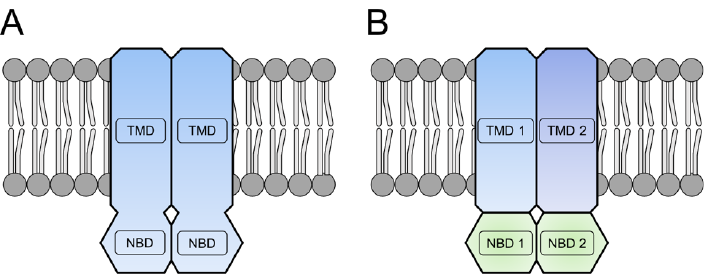
Figure 1. Domain organization of prokaryotic ABC exporters. ( A ) : Half-size homodimer. ( B ) : Single domain heterodimer. TMD = transmembrane domain. NBD = nucleotide-binding domain. The